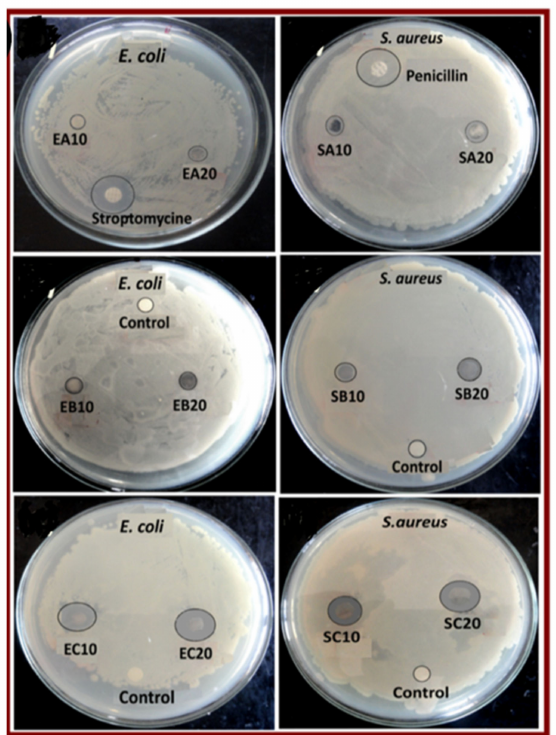
Figure 5. Zone of inhibition observed of AgNPs − PANI, Ag NPs − PANI/MWCNTs on E. coli and S. aureus. (Reprinted from Ref. [85]).